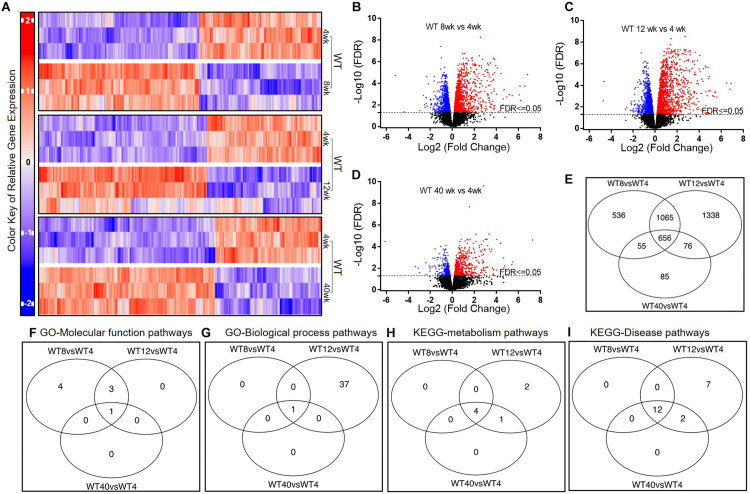
Gene expression in AMs from wild type mice across age groups. (A) Up-regulated and down-regulated genes in AMs at 4, 8, 12, and 40 weeks; (B–D) Volcano plots of significantly up-regulated (red) and down-regulated (blue) genes (FDR < 0.05); (E) Venn diagrams of the significantly changed genes; Venn diagrams of the significantly changed gene sets in AMs of the WT mice at different ages including GO-Molecular function pathways (F), GO-Biological process pathways (G), KEGG-metabolism pathways (H), and KEGG-Disease pathways (I). FDR < 0.05 was considered significant; FC, fold change.